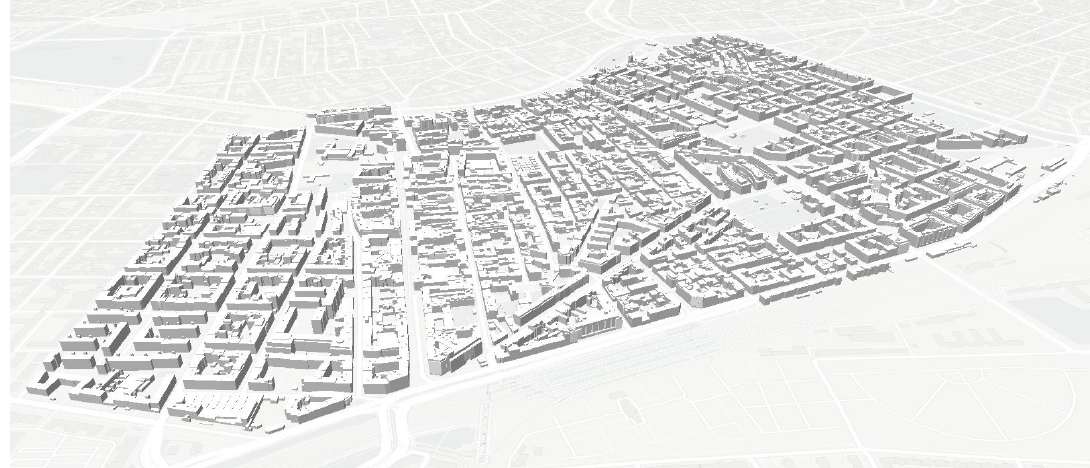
Figure 1. 3D model of the study area: Base case depicting the current volumes developed from the Land Use and Zoning Plan of the City of Vienna [46].